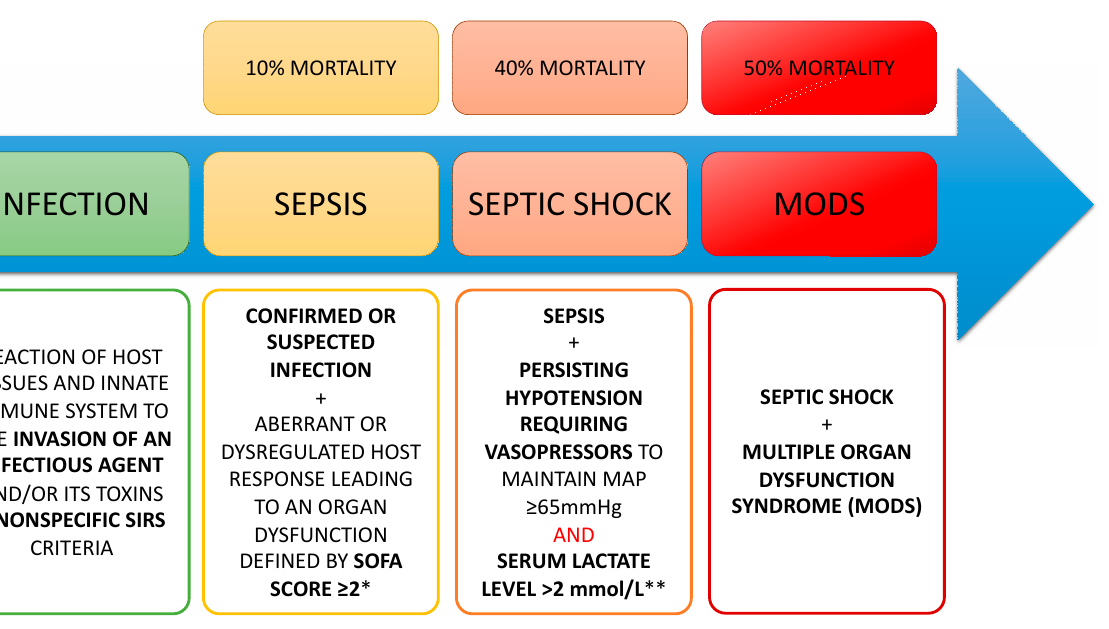
Figure 1. Diagram representing the continuum between infection by a pathogen and the occurrence of sepsis complicated or not with a state of shock or even a picture of multi-organ failure and their respective definitions in accordance with the recommendations of the task force and from the survival sepsis campaign. MAP: mean arterial pressure; SOFA score: Sepsis-related Organ Failure Assessment Score.